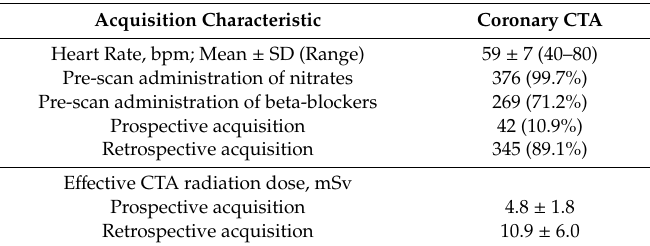
Table 2. Coronary CTA acquisition characteristics.